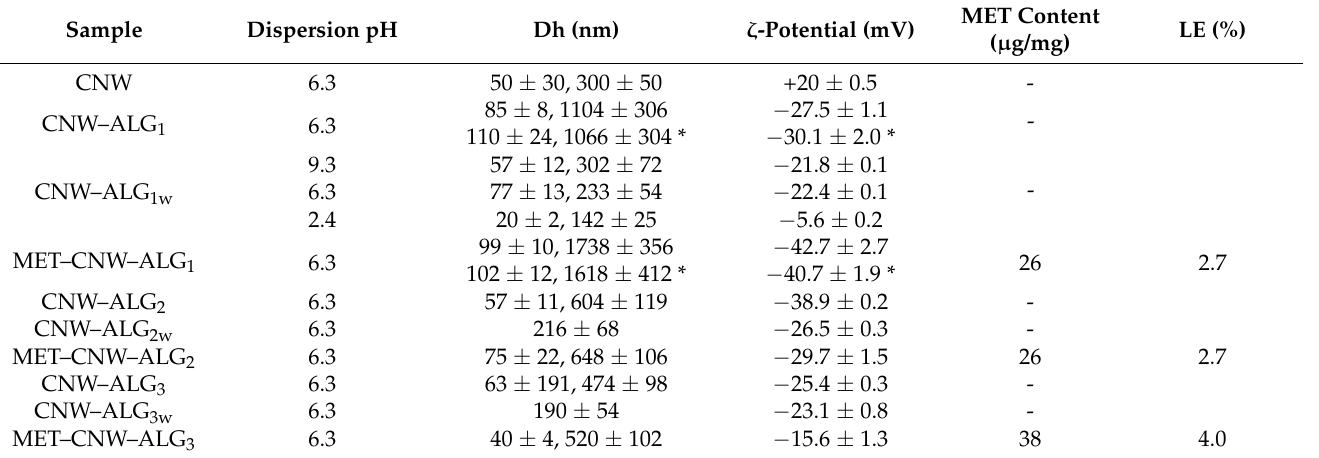
Physicochemical parameters of CNW–ALG and MET–CNW–ALG. Data represent mean ± standard deviation ( n =